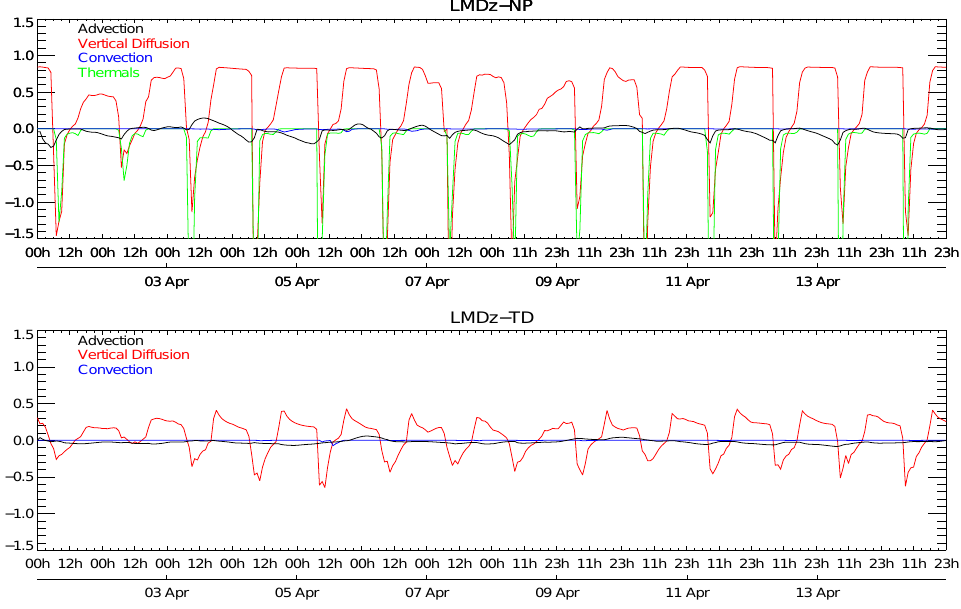
Figure 5. Time series of advection (black), vertical diffusion (red), convection (blue) and thermal (green) trends at Heidelberg station in the beginning of April 2009 for NP simulation (top) and TD simulation (bottom). The unit is Bqm − 3 h − 1